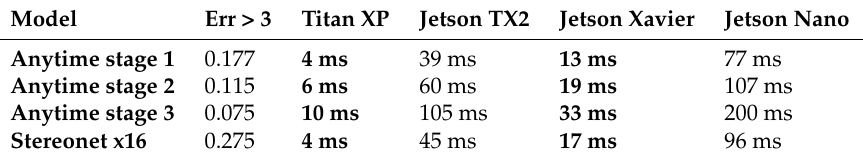
Table 2. Runtime and error performance for anytime-stereo and stereonet models. Anytime stage 1 corresponds to anytime-stereo disparity estimation at 1/16 of the original resolution, anytime stage 2 at 1/8, and anytime stage 3 at 1/4. Stereonet was used without refinement steps at 1/16 of the original resolution. Real-time performance is marked in bold where lower is better. A Titan XP (Pascal) GPU is used as a reference of high-end desktop GPU performance. The disparity error (Err > 3) of each model (row) is the same in all devices.